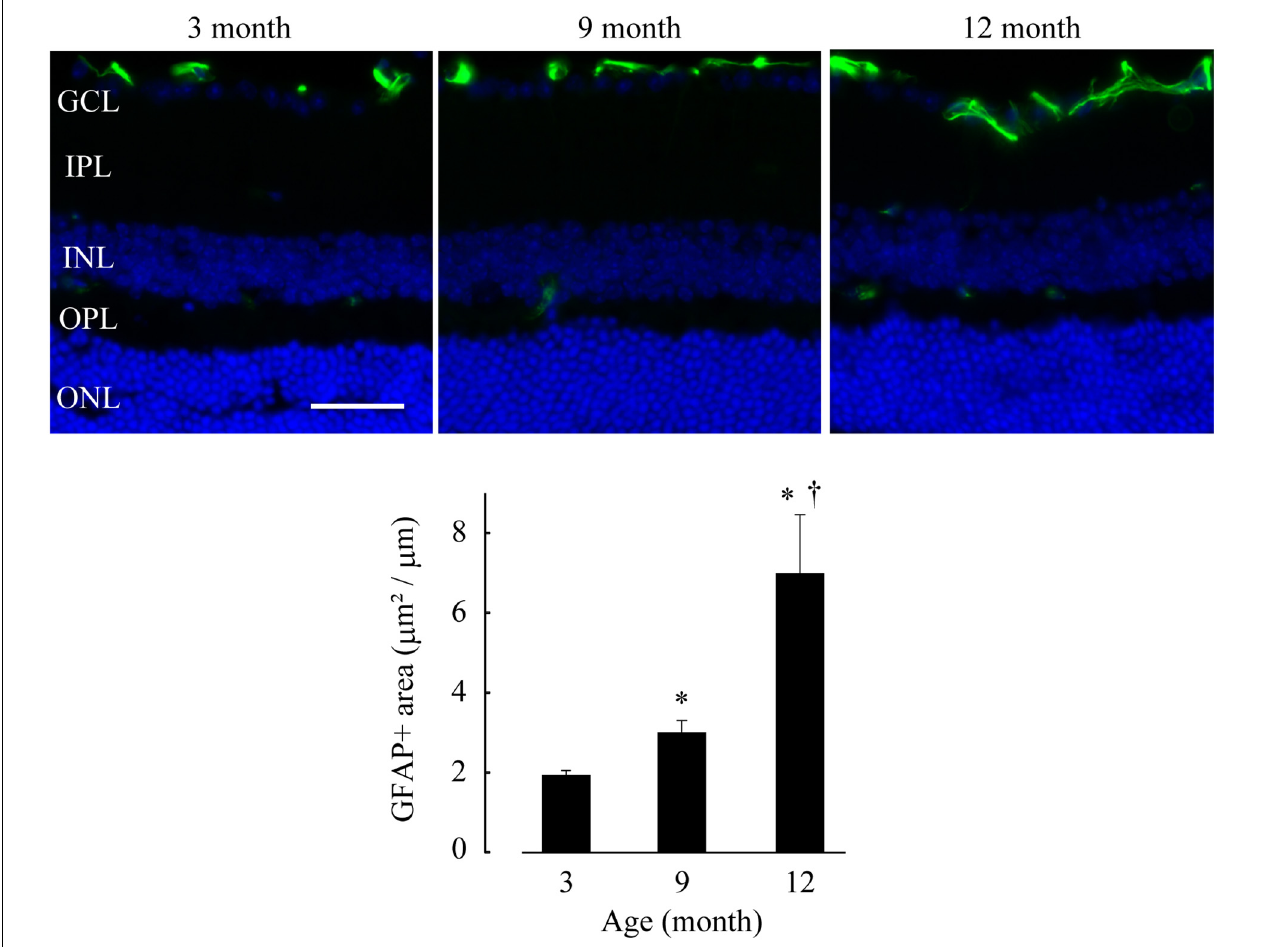
FIGURE 7 | Glial activation was observed in the retinae of DBA/2J mice after 9 months of age. GFAP immunohistochemistry (green) was performed on frozen sections of DBA/2J mice retinae at 3, 9 and 12 months of age. The sections were counterstained with DAPI (blue). Bar = 40 µ m. The average GFAP-positive area in retinae (positive area/horizontal length) is shown in a graph. * p ≤ 0.05 vs. 3 months, † p ≤ 0.05 vs. 9